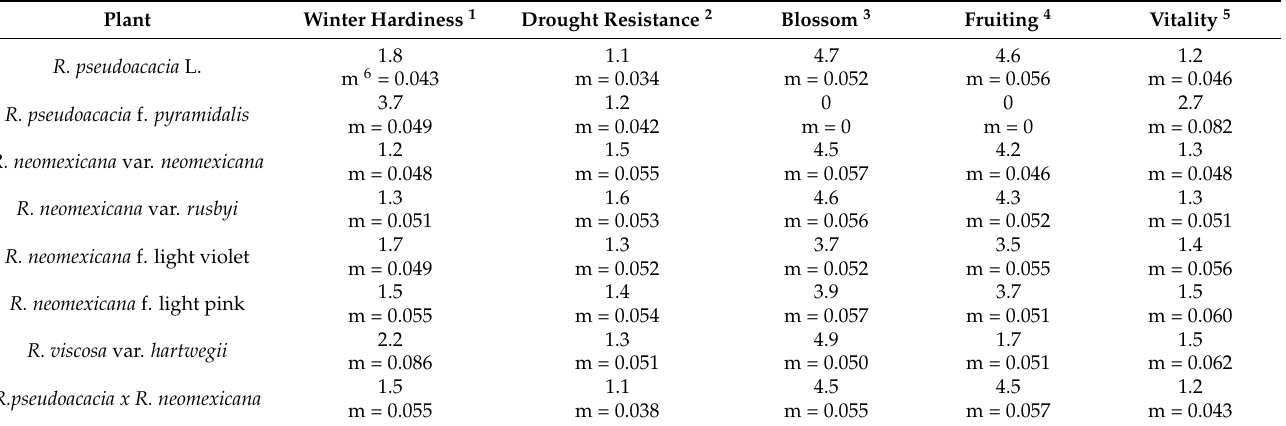
Table 2. Comprehensive assessment of the indicators of the prospects of introduction according to visual